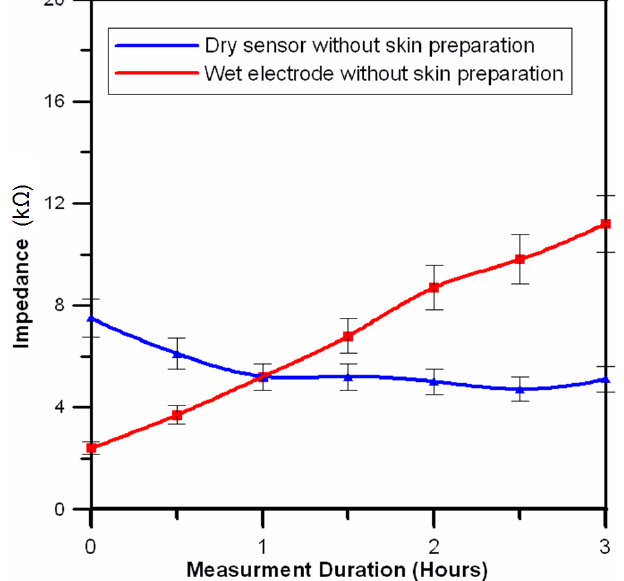
Figure 6. Long-term impedance variation measurements on the forehead site (F10) for wet and dry